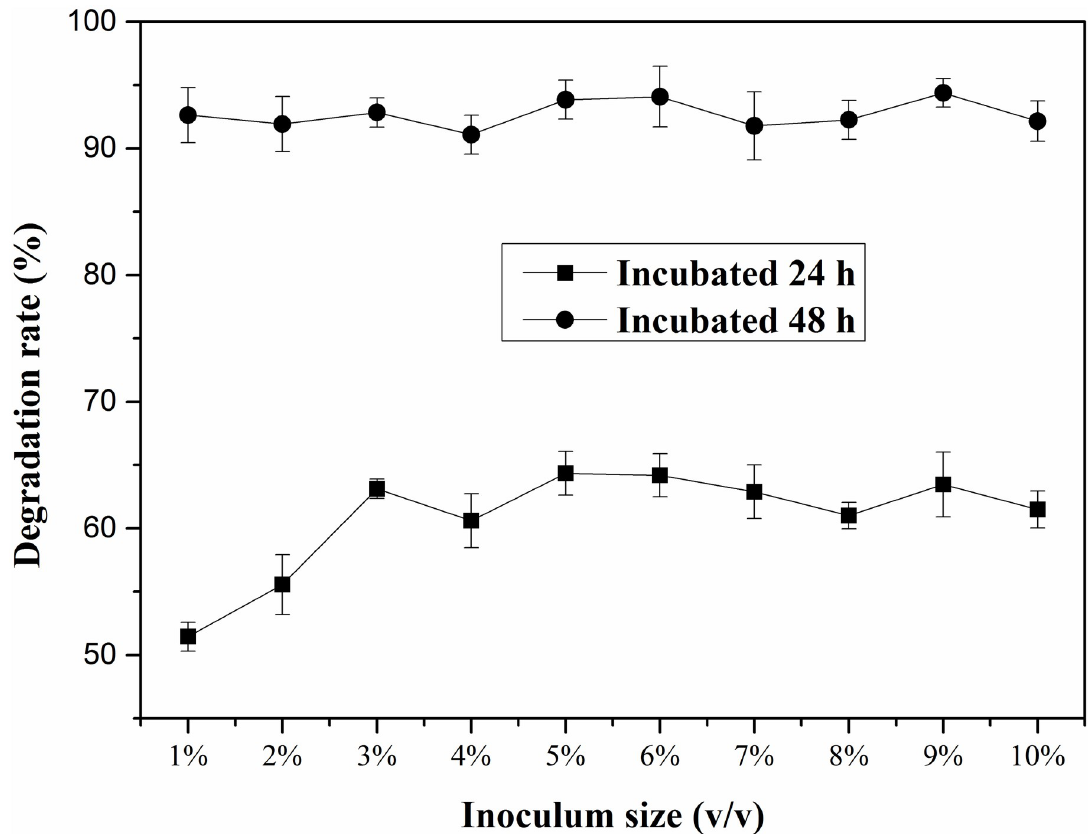
Fig 4. Effects of inoculum size on DEHP degradation by LF. Average values of three replicates are shown with the standard error of the mean as error bars.